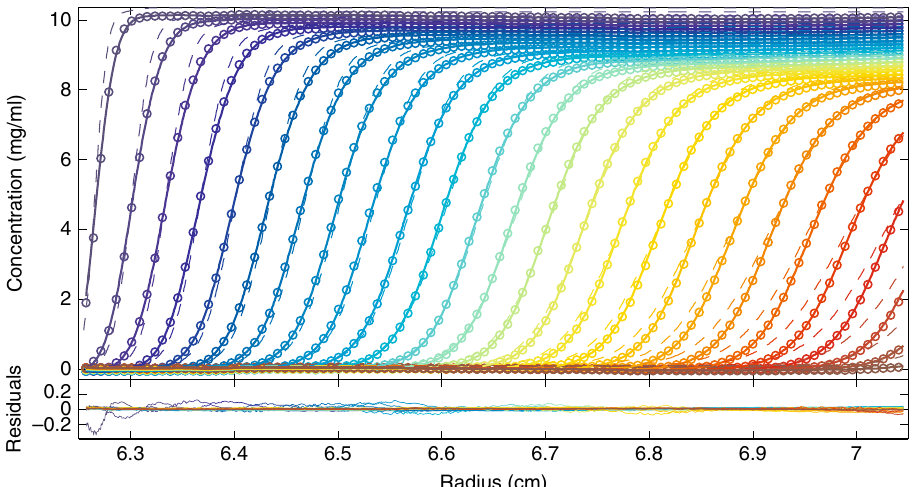
Fig. 1 Sedimentation velocity analysis of NISTmAb at 10 mg/ml. Interference data of NISTmAb stock solution in 25 mM histidine buffer, sedimenting at 45,000 rpm in 3 mm centerpieces, are shown with color temperature gradient indicating the boundary migrating from left to right (circles, for clarity only every 10th point is shown). The sedimentation model accounting for nonideality, c NI ( s 0 ), is shown as solid lines, leading to an rmsd of 0.015 fringes. For comparison, the best- fi t standard ideal model c ( s ) is shown as dashed lines, leading to an rmsd of 0.098 fringes. In the nonideal model the frictional ratio is fi xed to 1.6, whereas in the standard ideal model the frictional ratio is re fi ned to a best- fi t value of 3.5. The lower panel shows residuals of the c